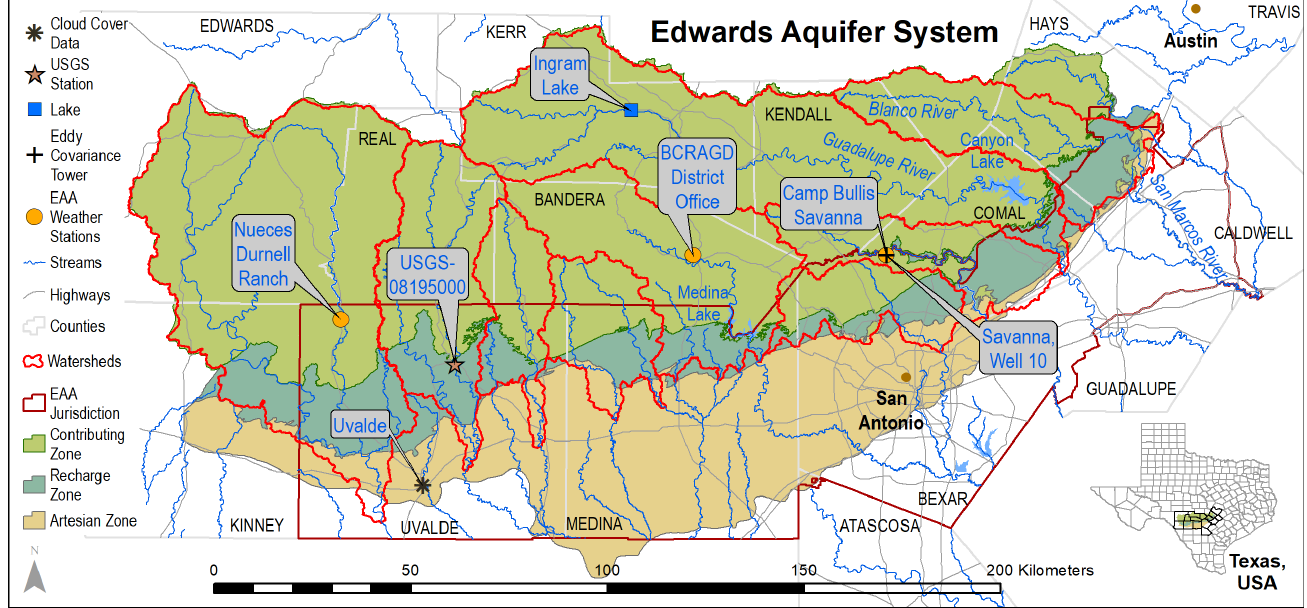
Figure 1. Data source locations across the Edwards aquifer region. The map shows the location of EAA’s weather stations with local climate data, the U.S. Geological Survey (USGS)’s station with surface water temperature data, Ingram Lake with estimated lake evaporation data, Uvalde city with the cloud cover data, and the eddy covariance tower with the actual evapotranspiration